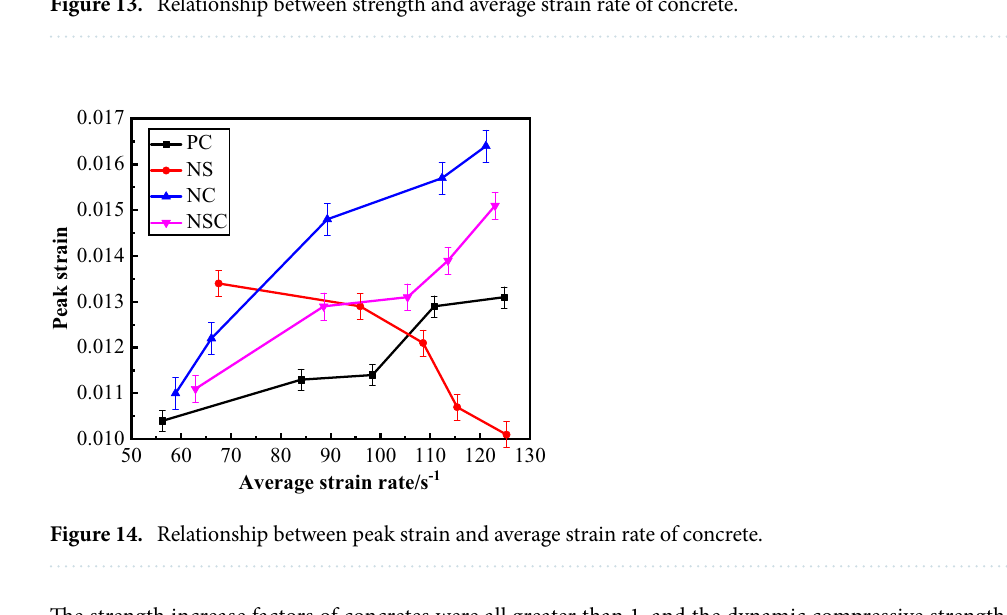
Figure 13. Relationship between strength and average strain rate of concrete.